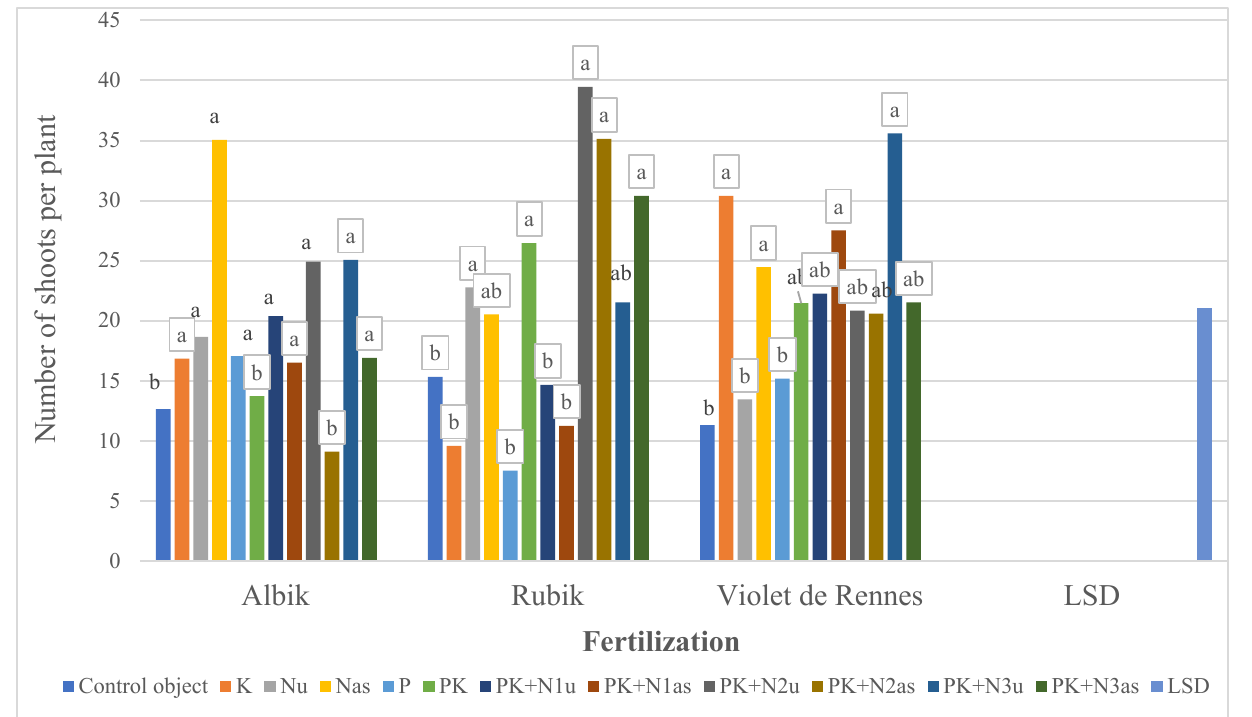
Figure 6. Effect of mineral fertilization and varietal properties on the number of shoots (2016–2018); designations as in Table 5. Legend: control object—N 0 P 0 K 0 ; P—43 kg P . ha − 1 ; K—124 kg K . ha − 1 ; as—